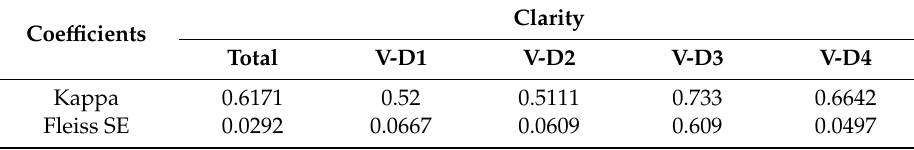
Table 1. Cohen’s Kappa values for inter-rater variability on the scale of